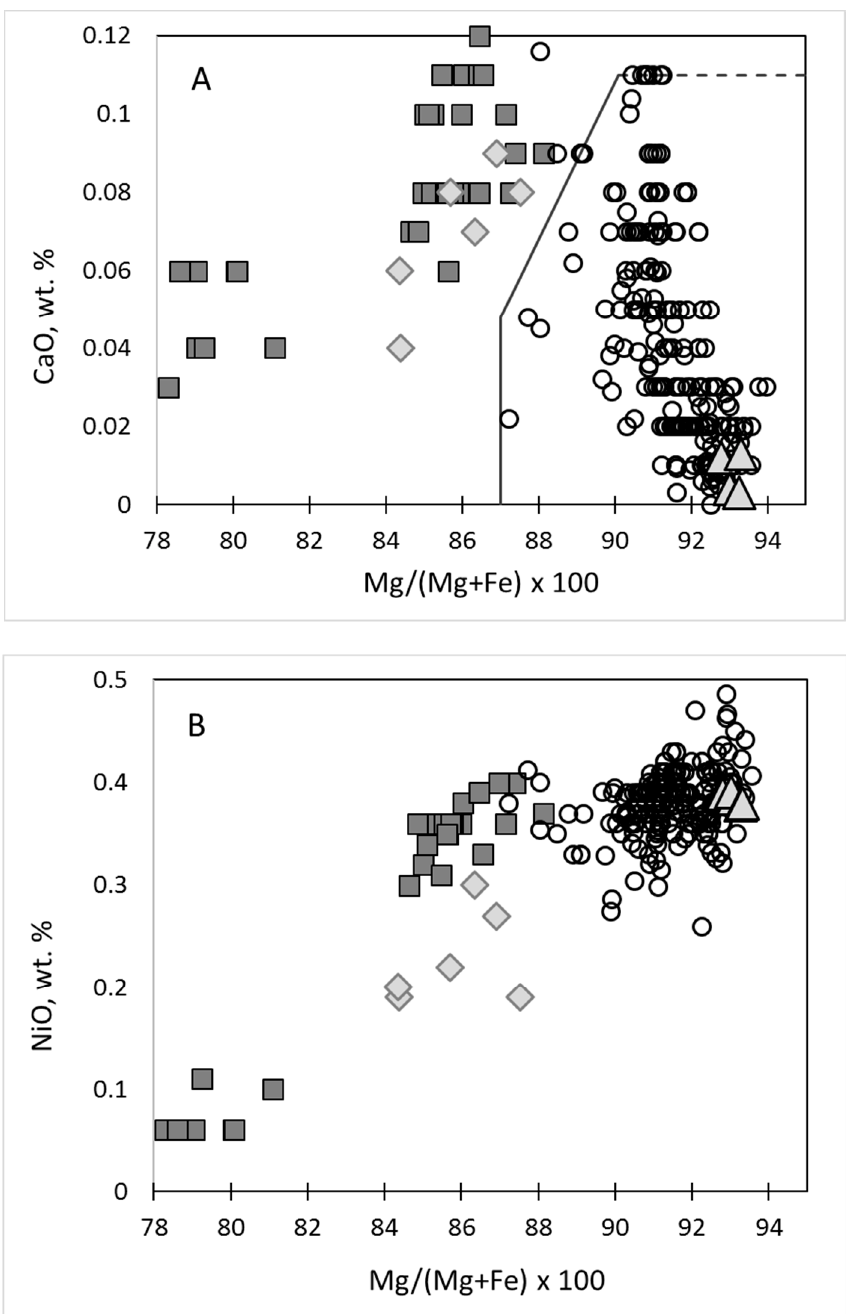
Figure 1. Division boundary (solid line) between low-Cr olivine megacrysts from kimberlite (squares and diamonds stand for Monastery [28] and Jagersfontein [9] kimberlites, respectively) and olivines from 230 peridotitic xenoliths (circles) from different kimberlites [22,30–36,38,39]. The dotted line separates high-Ca magmatic olivine [41]. Triangles are olivines from megacrystalline pyrope peridotites from Udachnaya [40,42], shown for comparison with low-Cr megacryst assemblage.